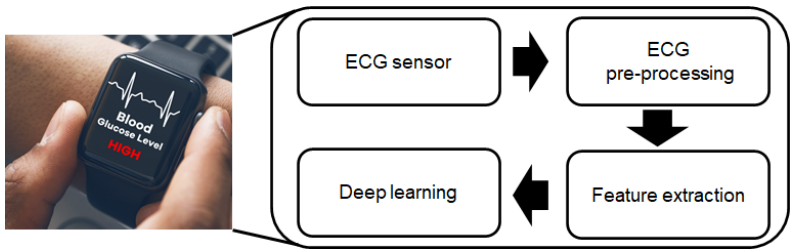
Figure 1. Illustrative schematic of proposed ECG-based hyperglycemia